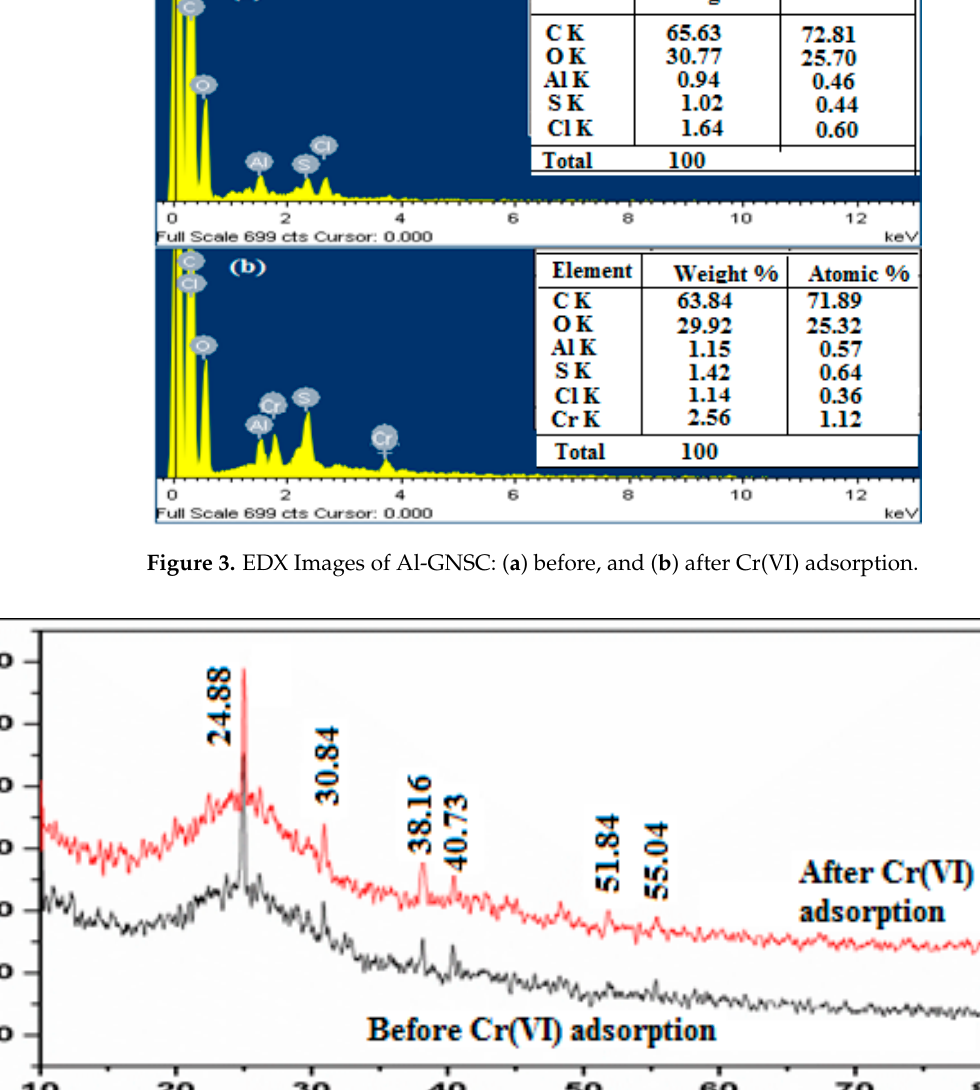
Figure 3. EDX Images of Al-GNSC: ( a ) before, and ( b ) after Cr(VI) adsorption.